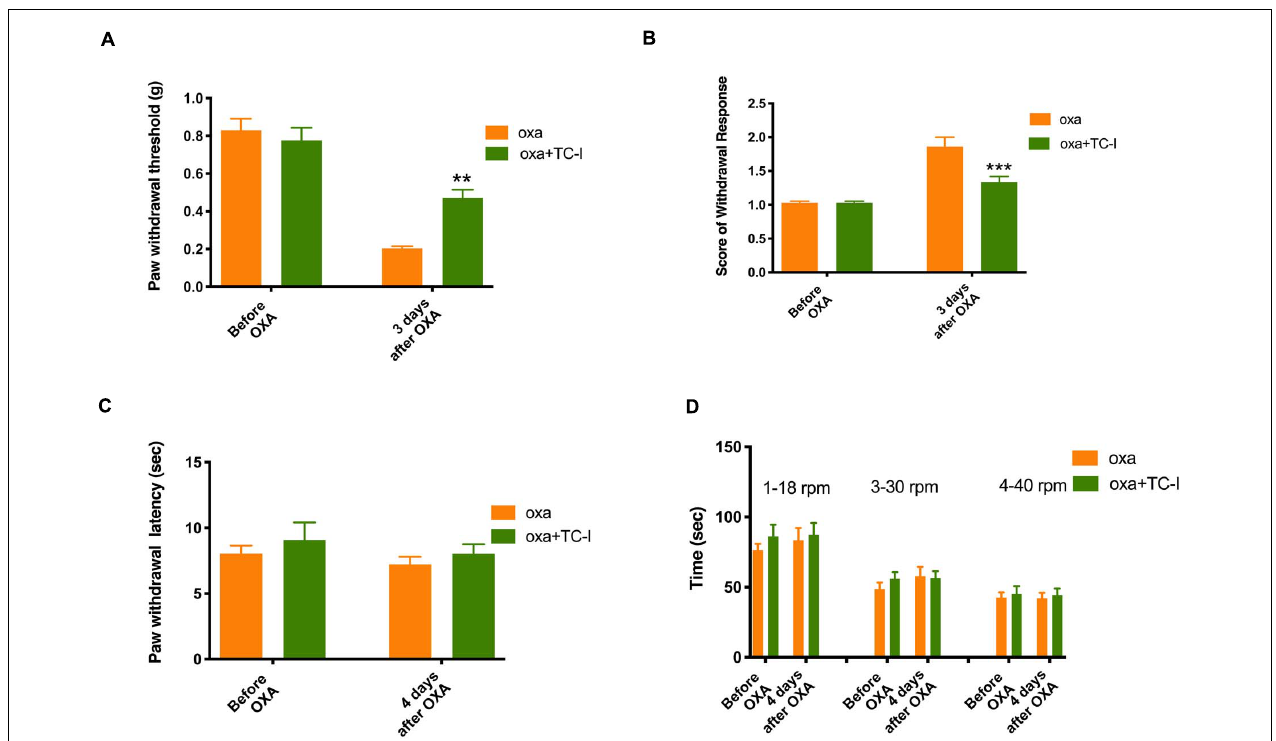
FIGURE 5 | Effects of TC-I on the sensory and motor behaviors following oxaliplatin treatment. The administration of oxaliplatin, the schedule for TC-I (10 mg/kg, ip) treatment (same to the Retigabine treatment), the testing schedule for different types of behaviors were described in the Legend of Figure 3 . (A) Paw withdrawal threshold to Von-Frey filament; (B) Score of withdrawal response to acetone; (C) Paw withdrawal latency to radiant heat; and (D) Time stayed on rod at different speeds in rotarod tests ( n = 6 for all groups). **, P < 0.01; ****, P < 0.0001; two-way repeated measure